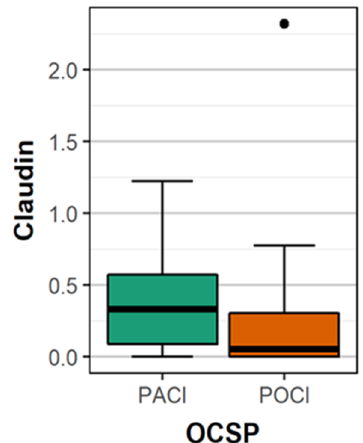
Figure 2. The comparison of the mean concentration of claudin 5 between patients with PACI and POCI.